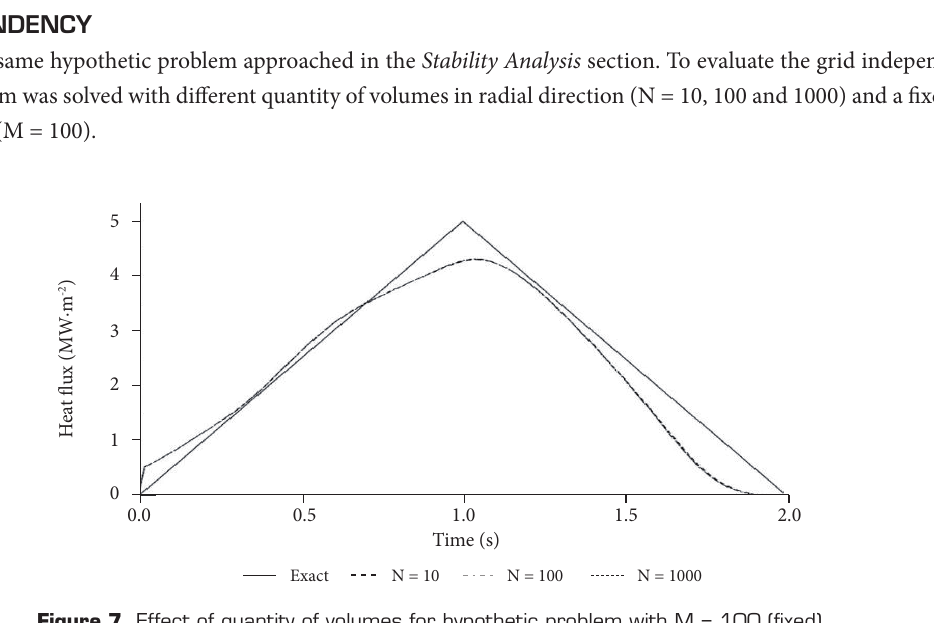
Figure 7. Effect of quantity of volumes for hypothetic problem with M = 100 (fixed).